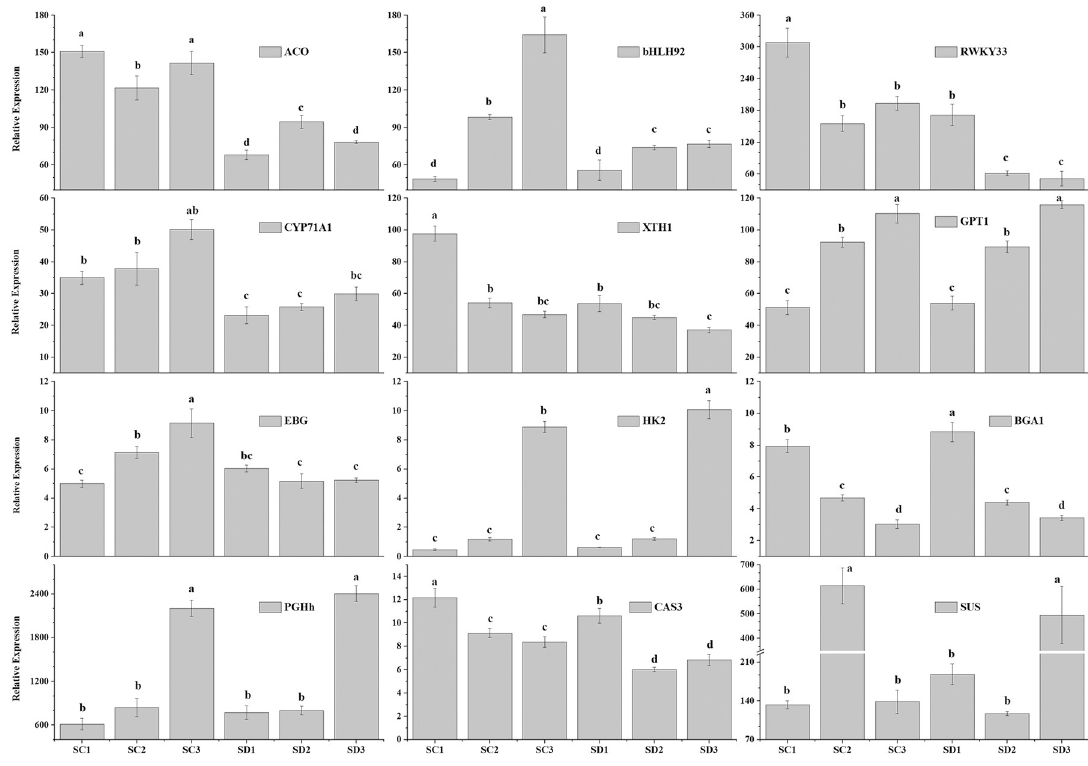
Fig 10. Verification of the selected genes related to the pistil abortion by qRT-PCR. The x-axis indicates the different stages. The y- axis shows the qRT-PCR expression values. The qRT-PCR values were determined by the actin (ACT) gene as an internal reference using the 2- ΔΔ CT values. All values were repeated three times and the data are presented as the mean ± SD. Different letters indicate significant differences at P < 0.01. ACO: CU_locus22526; CYP71A1: CU_locus30850; WRKY33: CU_locus40517; bHLH92: CU_locus476; XTH1: CU_locus1414; EBG: CU_locus7296; HK2: CU_locus39380; GPHh: CU_locus35718; CAS3: CU_locus34862; BGA1: CU_locus24690; SUS: CU_locus46184; GPT1: